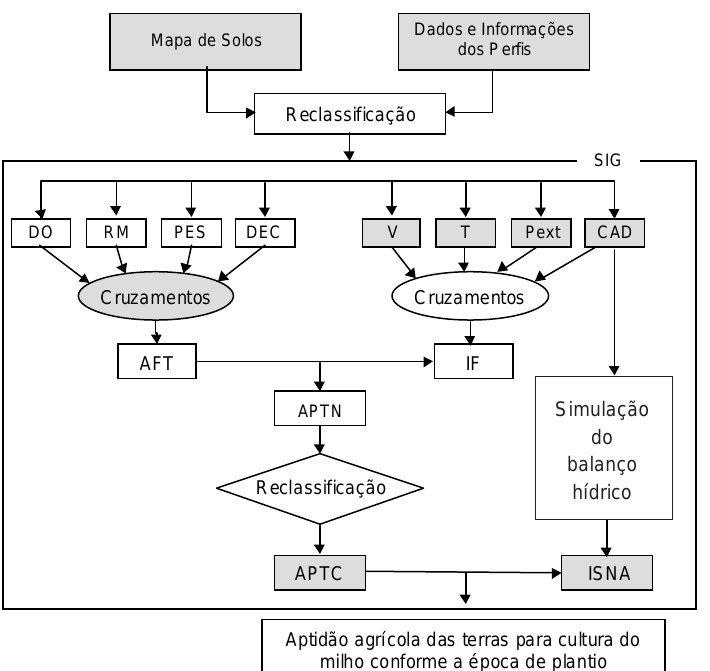
DO: Deficiência de oxigenação; RM: Restrição à mecanização; PES: Profundidade dos perfis; DEC: Declividade; T: Capacidade de troca catiônica; Pext.: Fósforo extraível; IF: Indicativo de fertilidade; CAD: Capacidade de água disponível; AFT: Aptidão física das terras; APTN: Aptidão natural das terras; APTC: Aptidão agrícola em nível de manejo C; ISNA: Índice de satisfação de necessidade de Figura 1. Fluxograma do método de determinação da aptidão agrícola das terras da Bacia do rio Jardim (DF) com estimativa do risco climático para cultura do milho.